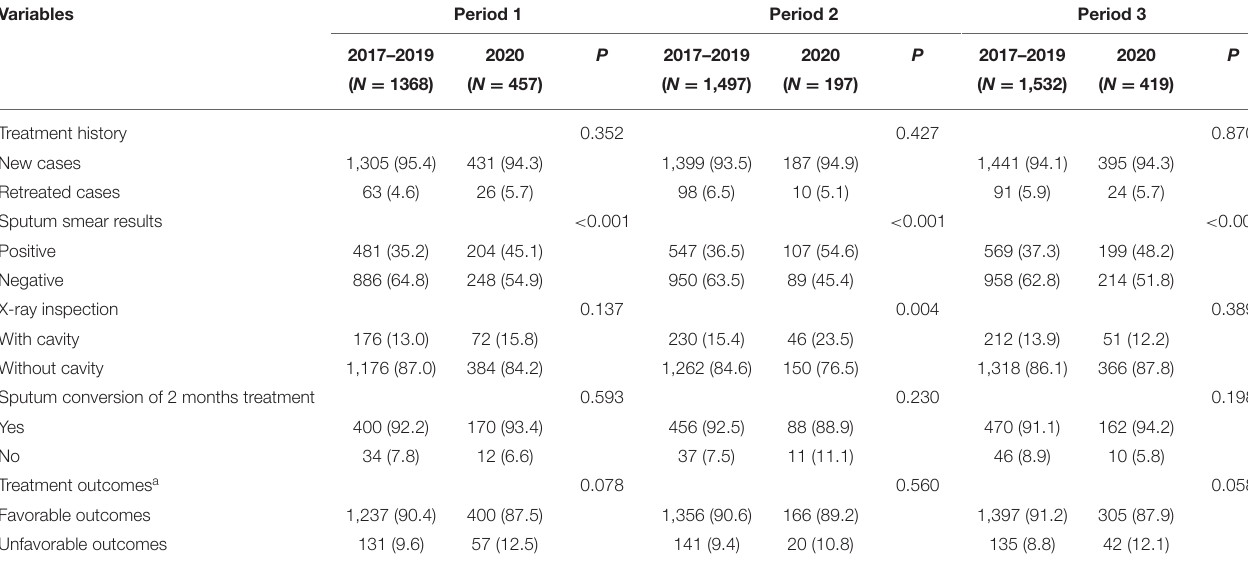
TABLE 1 | Comparison of clinical characteristics of TB cases by three periods between the 2020 COVID-19 periods and 2017–2019 baseline.